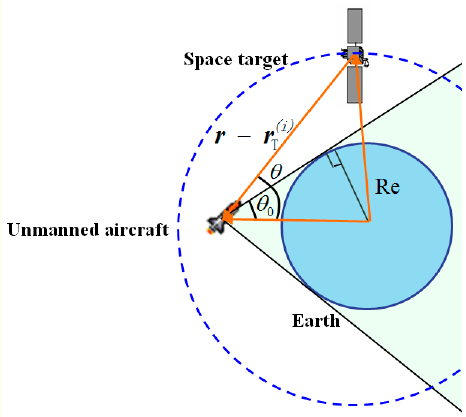
Figure 5. Relative positions of the Earth, aircraft and target.